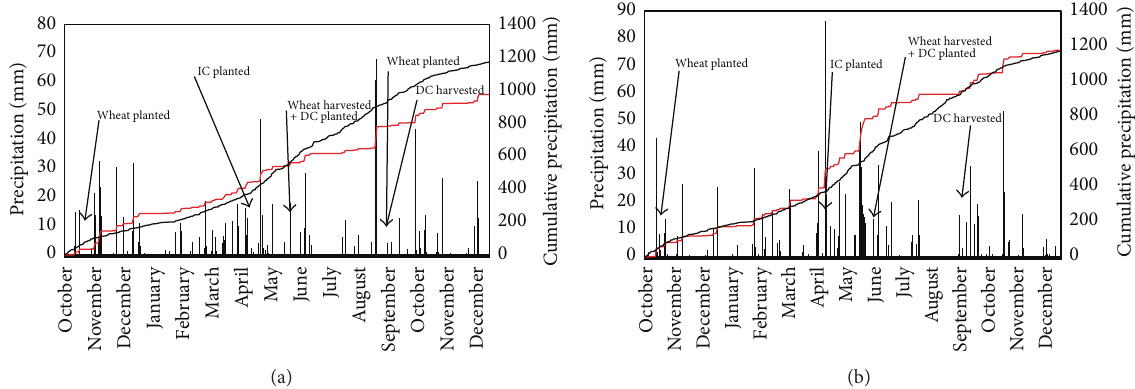
Figure 1: Daily (bar) and cumulative precipitation data for individual years (red line) and 10-year average (black line) for experiment from 2011 to 2012 (a) and 2012 to 2013 (b). Double-crop (DC), relay-intercrop (IC) planting, and harvest dates for wheat and alternative crops were labeled with arrows.